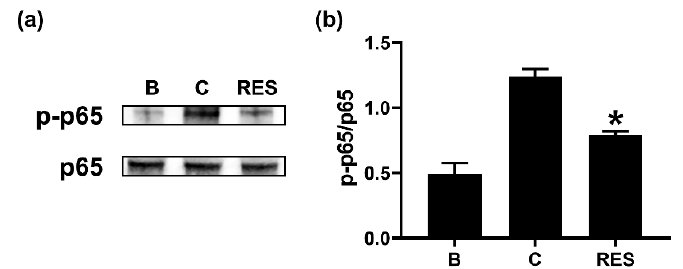
Figure 6. Effects of RES on the phosphorylation of NF-kB in neutrophil-like dHL-60 cells. ( a ) dHL-60 cells (5 × 10 6 ) were exposed to RES (3 µM) for 1h, and then stimulated with GM-CSF (5 ng/mL) for 1 h. ( b ) The protein levels were quantitated by densitometry. B, PBS-added and unstimulated cells; C, PBS-added and GM-CSF-stimulated cells; RES, RES-added and GM-CSF-stimulated cells. Data are shown as the mean ± SEM of three independent experiments. * p < 0.05 vs. the PBS-added and GM-CSF-stimulated cells.